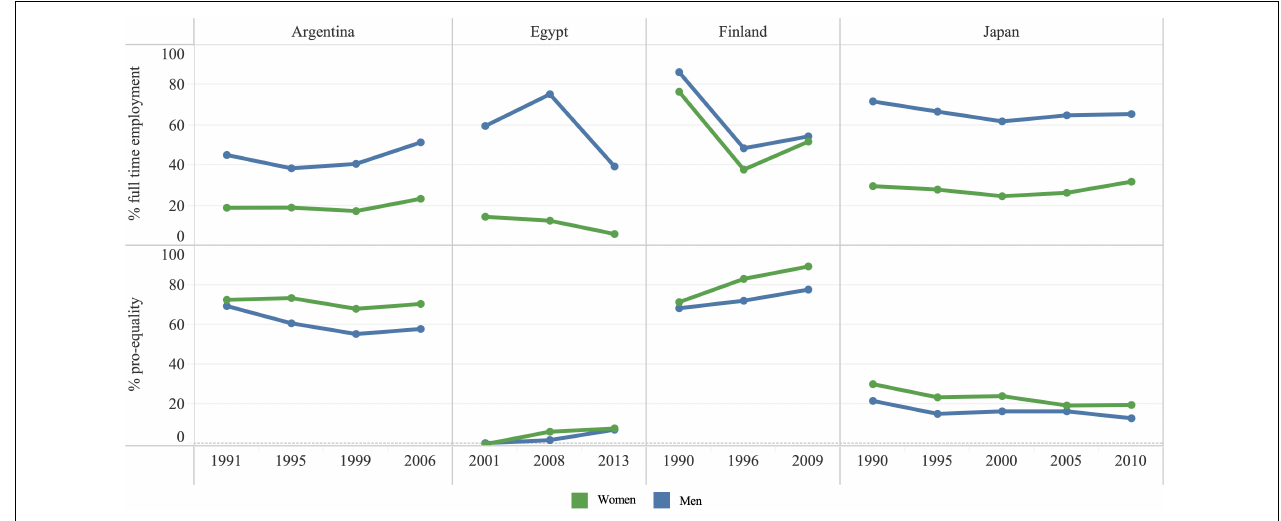
FIGURE 5 | Full-time employment, pro-equality norms, and self-reported health by sex in Argentine, Egypt, Finland, and